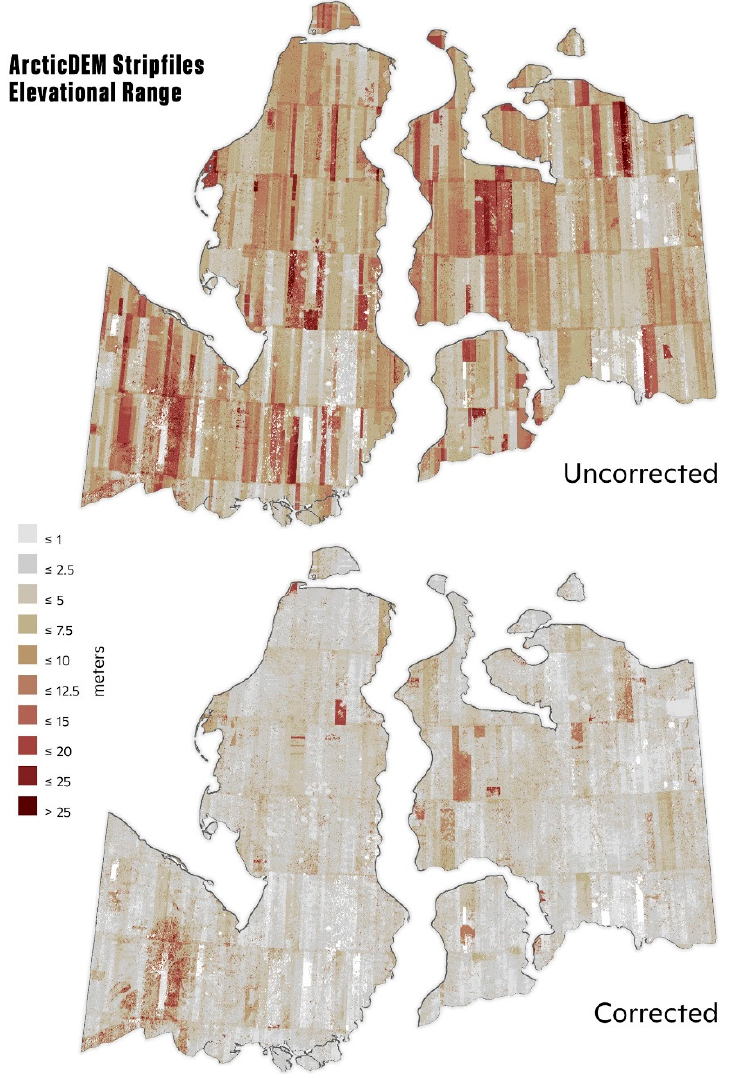
Figure A1. Change in elevation across the study area from 2008 to 2017, derived using the ArcticDEM digital surface model [13]. Vertical discrepancy among ArcticDEM strips (uncorrected, top panel) was corrected using the ICESat altimetry offset (corrected, bottom panel) (see Section 2.2).